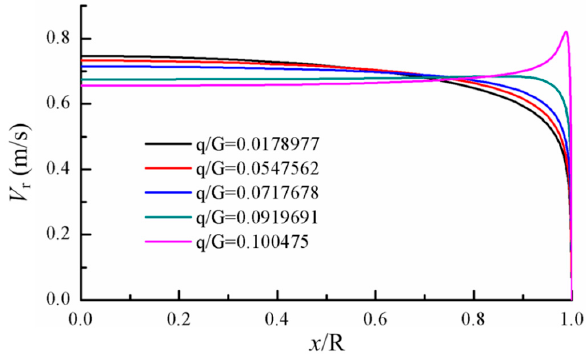
Figure 17. Distribution of the axial velocity ( x / D = 26). Energies 2017 , 10 , 1870